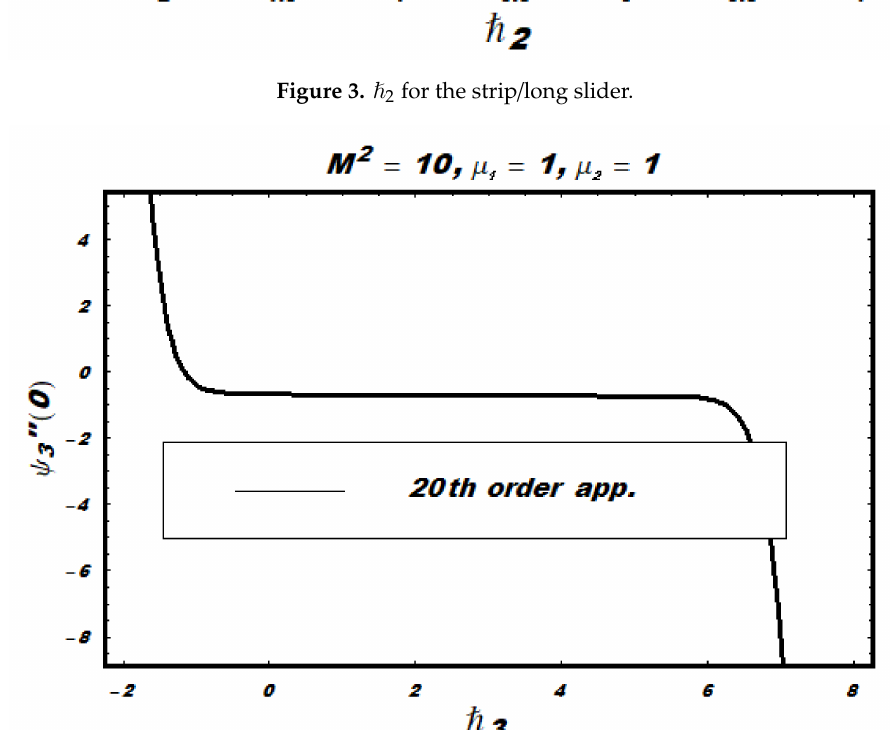
Figure 4. (cid:125) 3 for the strip / long